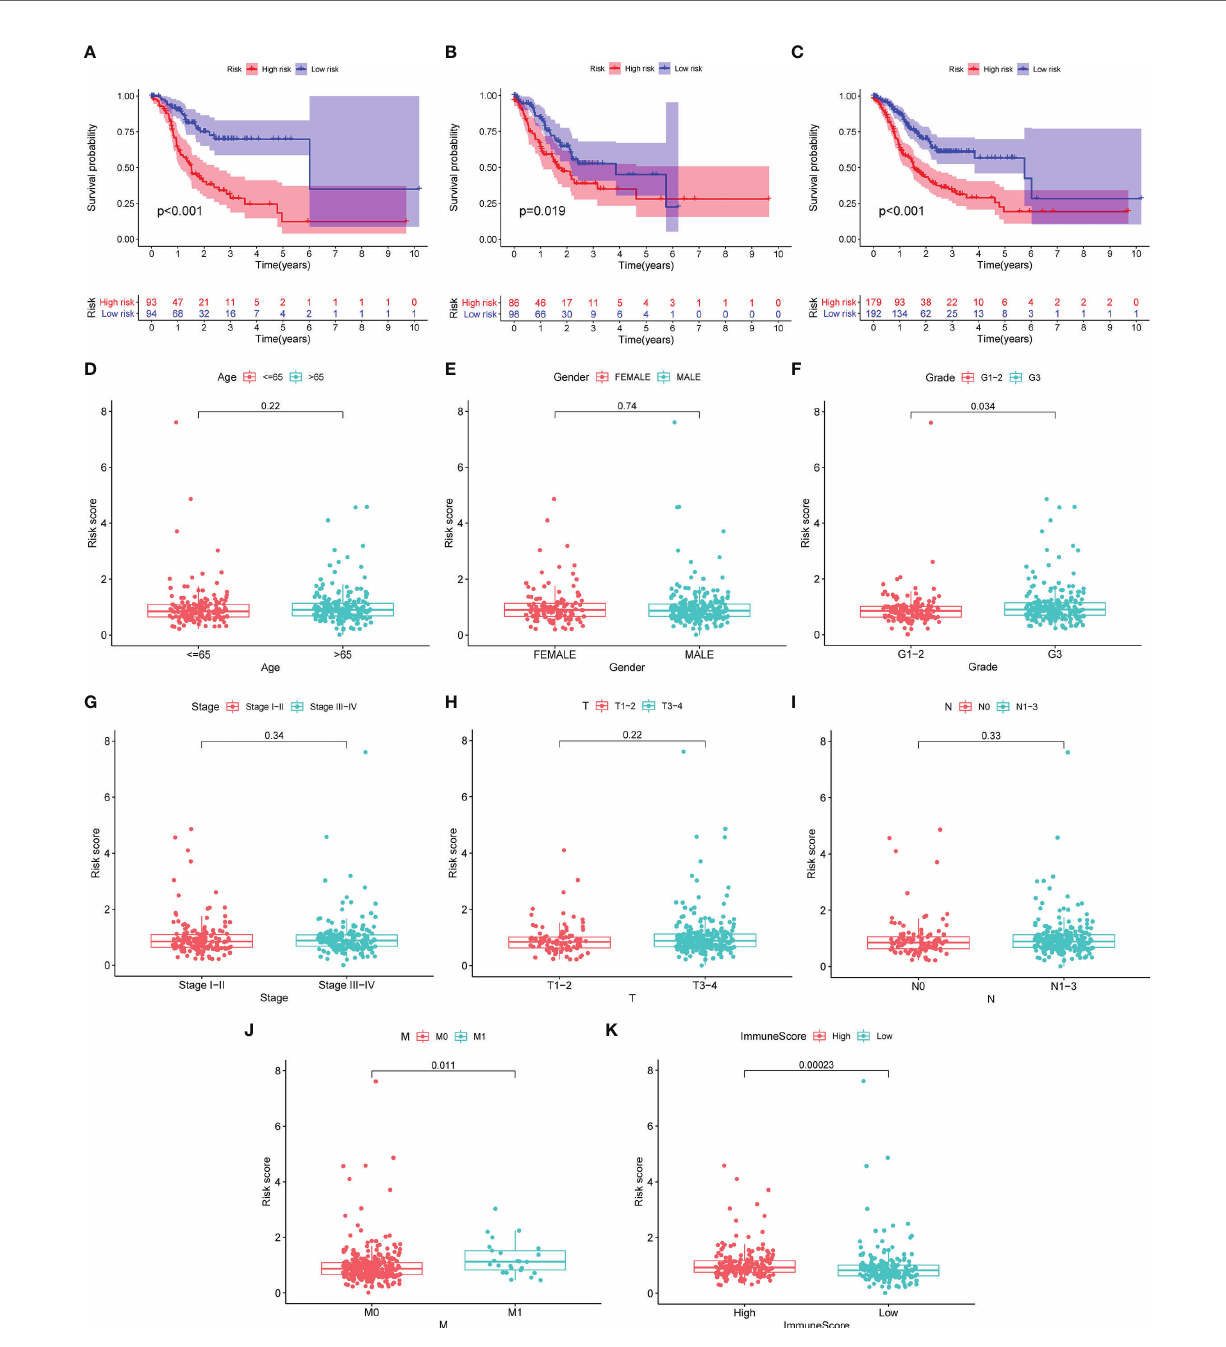
FIGURE 3 | The risk score correlated with overall survival and clinicopathological features. (A – C) Kaplan – Meier curves of GC patients between the high- and low- risk group in the training (A) , validation (B) , and total (C) set. (D – K) Comparison of risk score distribution between the two groups: age (D) , gender (E) , G1 – 2/G3 (F) , stage I – II/III – IV (G) , T1 – 2/T3 – 4 (H) , N0/N1 – 3 (I) , M0/M1 (J) , and high and low immunescore